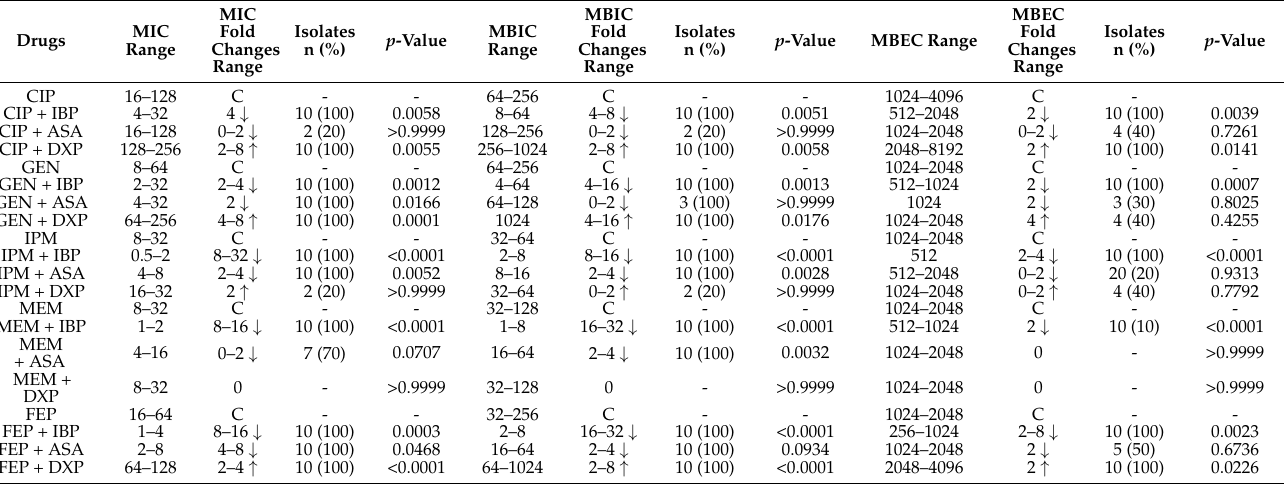
Table 3. The level changes of the MIC, MBIC, and MBEC of antibiotic agents with/without sub-MICs of anti-inflammatory drugs among MRSA isolates.